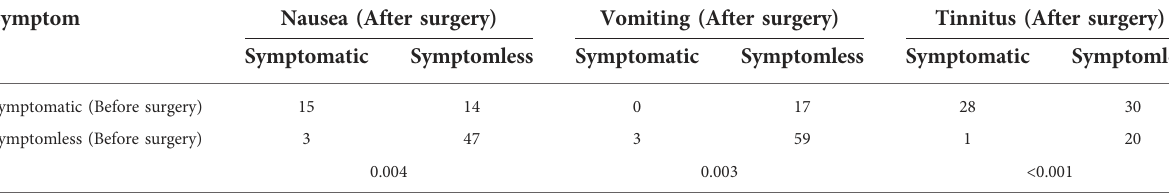
TABLE 10 Number of patients with nausea, vomiting or tinnitus before and after surgery. (x±, n =79). Symptom